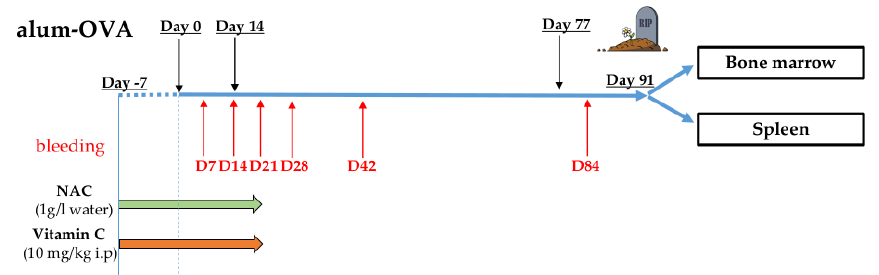
Figure 1. Vaccination protocol (see Materials and Methods). Mice were intraperitoneally (i.p.) injected with three doses of alum-OVA on days 0, 14, and 77. From day −7 until day 21, NAC was administered in the drinking water, and Vc and PBS (control group) were i.p. injected once per day. Blood was withdrawn from each mouse on days 7, 14, 21, 28, 42, and 84, and BM and spleen were harvested on day 91.